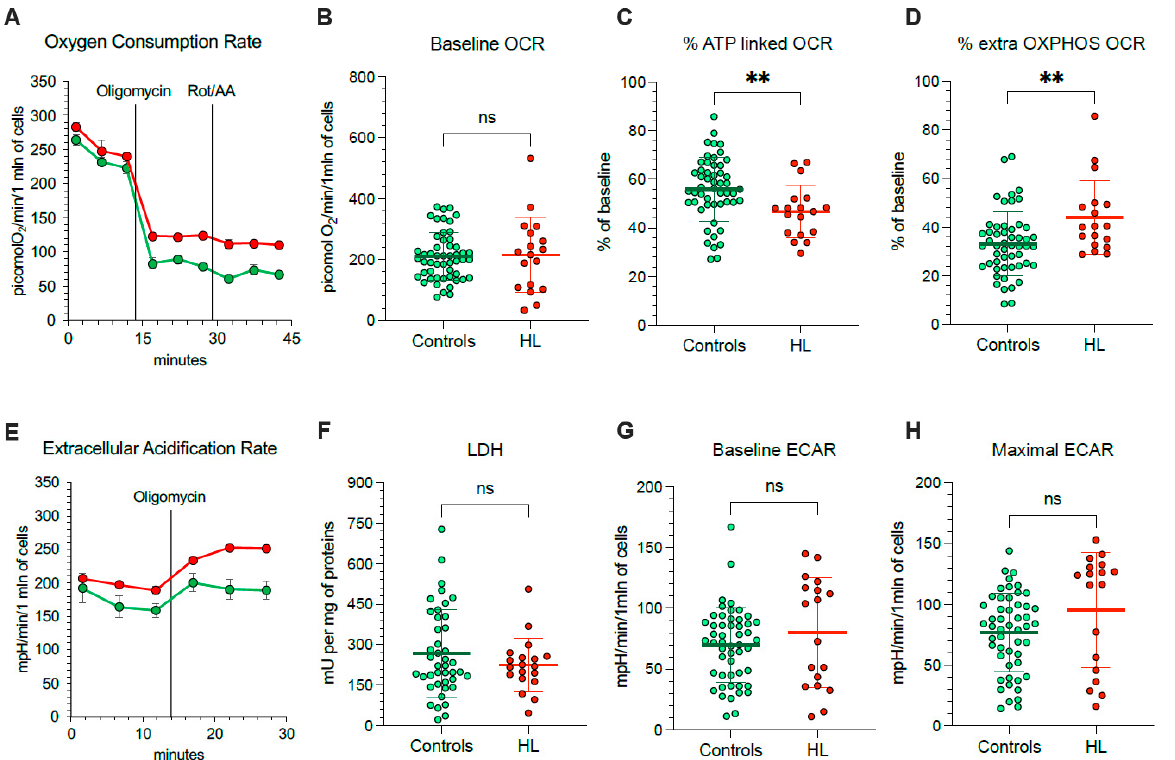
Figure 3. Mitochondrial energetic function in PBMCs. ( A ) Typical trace from the Seahorse XFp of oxygen consumption rate (OCR) over time (x-axis) measured on intact PBMCs (10 × 10 5 cells/well) collected from controls (green) and HL patients (red). Injections of ATP-synthase inhibitor Oligomycin A, and rotenone/antimycin A (Rot/AA) are indicated with black lines. Average and SD of at least 3 replicate wells are plotted. ( B ) Basal OCR measured in presence of glucose (11 mM) and ( C ) after injection of Oligomycin A expressed as % of corresponding basal OCR. ( D ) Extramitochondrial OCR after the inhibition of Complexes I, III, and V after sequential injection of Oligomycin A and Rot/AA, expressed as % of corresponding basal OCR. ( E ) Typical trace from the Seahorse XFp of extracellular acidification rate (ECAR) over time (x-axis) measured on intact PBMCs (10 × 10 5 cells/well) collected from controls (green) and HL patients (red). Injections of Oligomycin A is indicated with black lines. Average and SD of at least 3 replicate wells are plotted. ( F ) Lactate dehydrogenase (LDH) activity, ( G ) basal ECAR measured in presence of glucose (11 mM) and ( H ) maximal ECAR after injection of Oligomycin A. Graphs display individual data and mean ± SD. ** = p < 0.01.